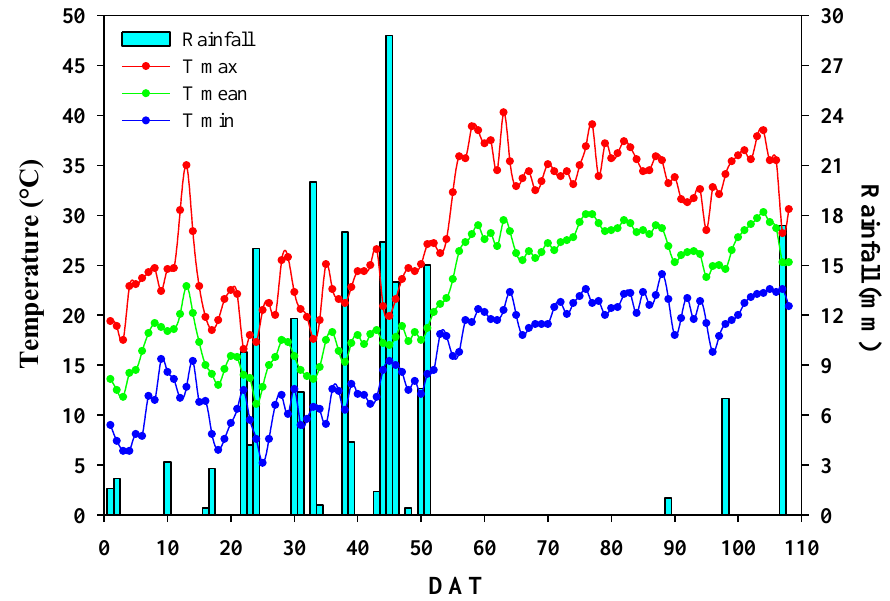
Figure 1. Minimum, mean and maximum air temperature and rainfall during the 2019 growing